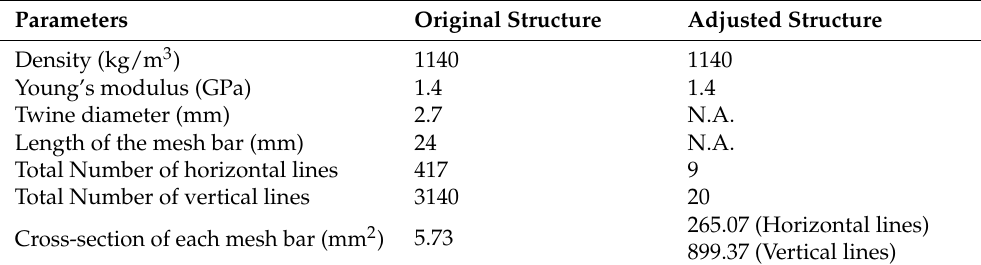
Table 1. Parameters of the adjusted structure and original